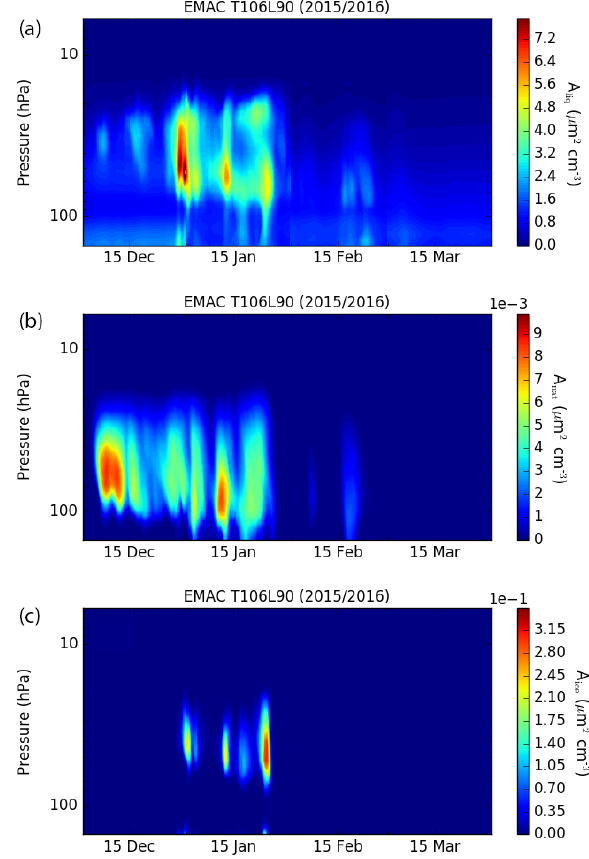
Figure 2. Temporal evolution of surface area density of STS (a) , NAT (b) and ice (c) particles at northern high latitudes (70–90 ◦ N) as a function of pressure during the 2015/2016 Arctic winter as simulated with EMAC T106L90. Note the differences in the colour bar for A liq (µm 2 cm − 3 ), A NAT (10 − 3 µm 2 cm − 3 ) and A ice (10 − 1 µm 2 cm − 3